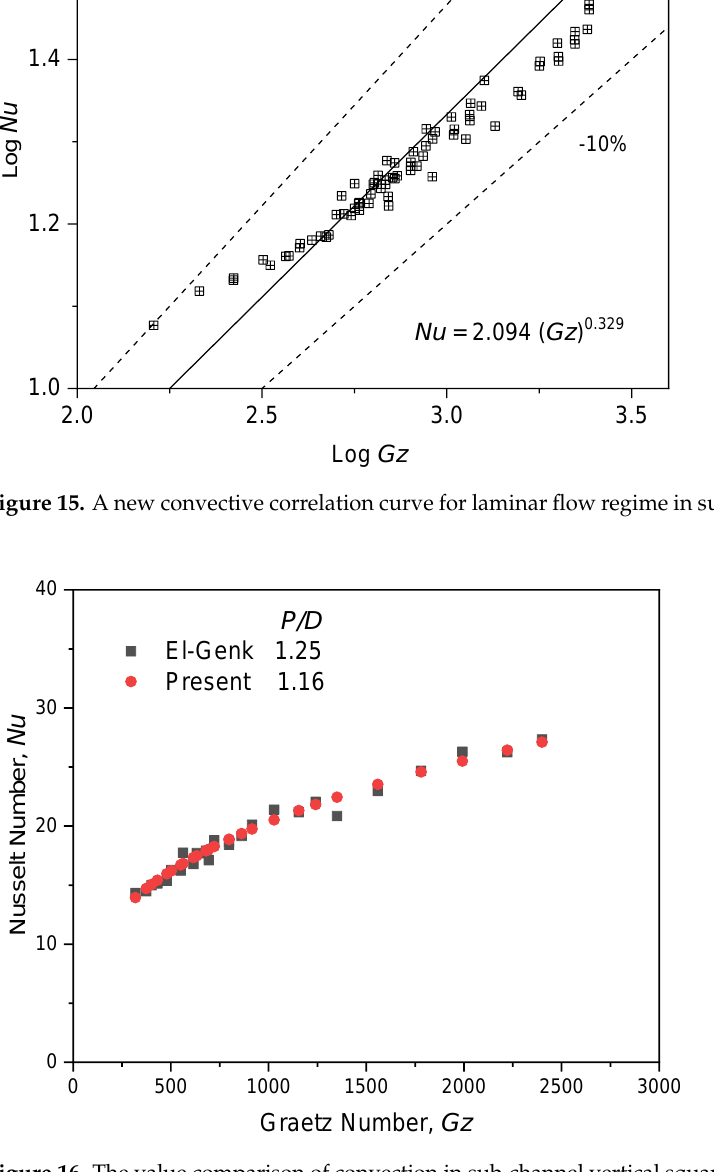
Figure 15. A new convective correlation curve for laminar flow regime in sub-channel vertical square.